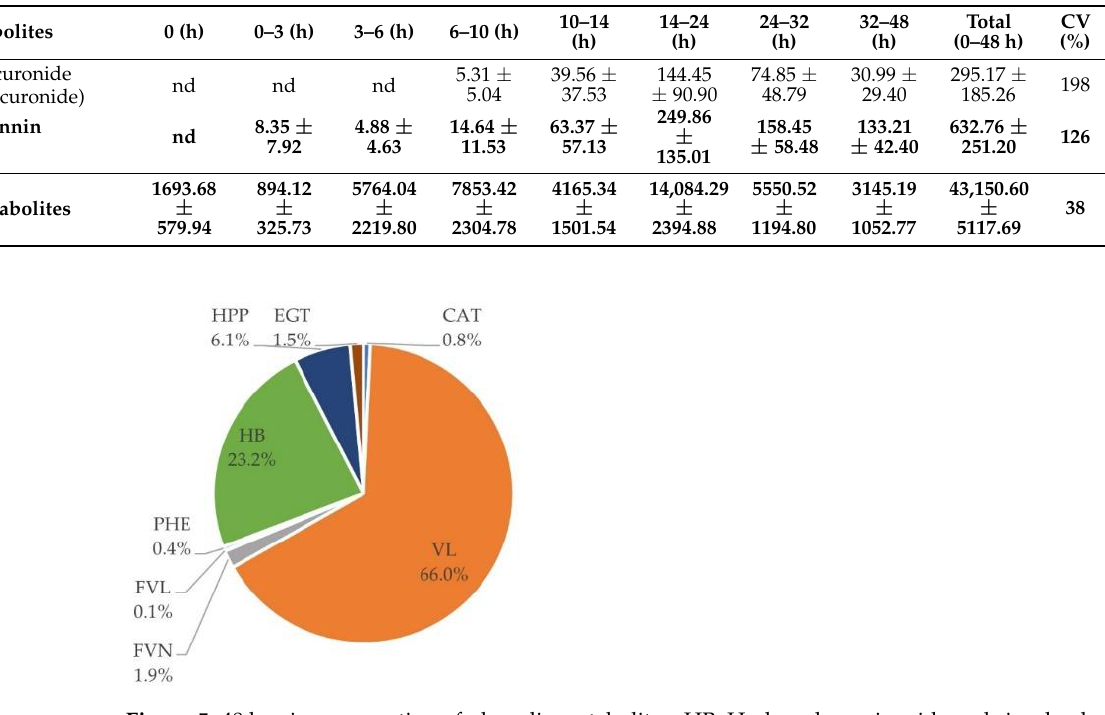
Figure 5. 48 h urinary excretion of phenolic metabolites. HB: Hydroxybenzoic acids and simple phenols; HPP: Hydroxyphenylpropanoic acids; FVN: Flavanone derivatives; VL: Phenyl- y-valerolactones and phenyl valeric acids; CAT: (Epi)catechin derivatives; PHE: Phenylethanoid derivatives; FVL: Flavonol derivatives. 4′ -hydroxyhippuric acid was not included. Flavan-3-ol derivatives were the most abundant compounds quantified, with the class of phenyl-y-valerolactone and phenylvaleric acid derivatives being predominant. Three (epi)catechin derivatives identified in plasma were also recovered in urine with an excretion peak of 3 and 6 h post-consumption, confirming a predominant absorption in the upper gastrointestinal tract (Figure 6A). Inter-individual variability in the excretion of these derivatives was high, as CV ranged from 71% to 164%. A total of 17 different phe-